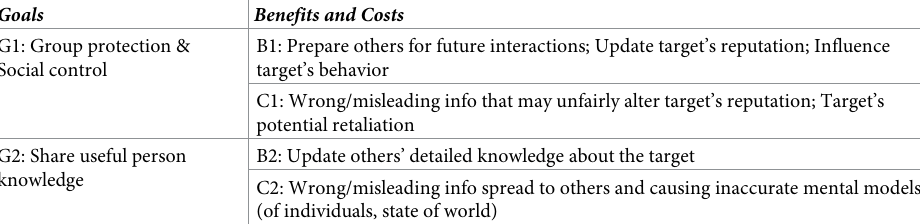
Table 3. Two main social goals as problems to solve. Key benefits and costs for achieving the goals are listed.